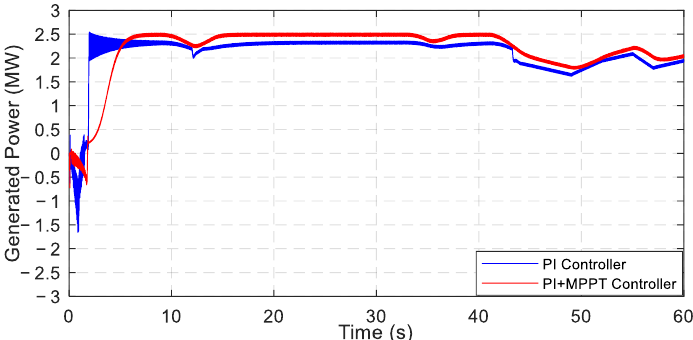
Figure 19. Generated power of the DFIG.